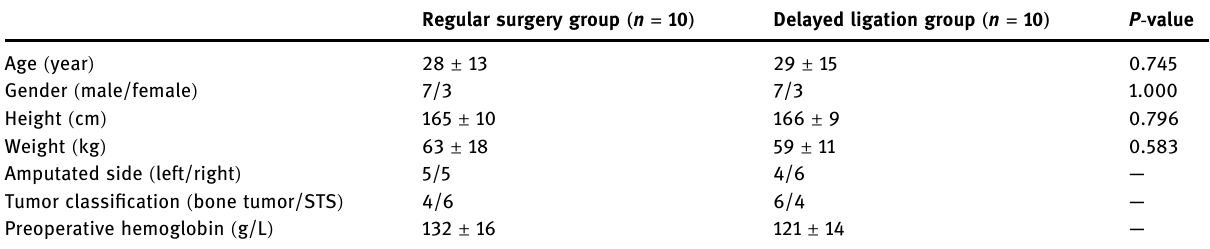
Table 1: Demographic and clinical characteristics of patients treated with regular surgery or delayed ligation hip disarticulation